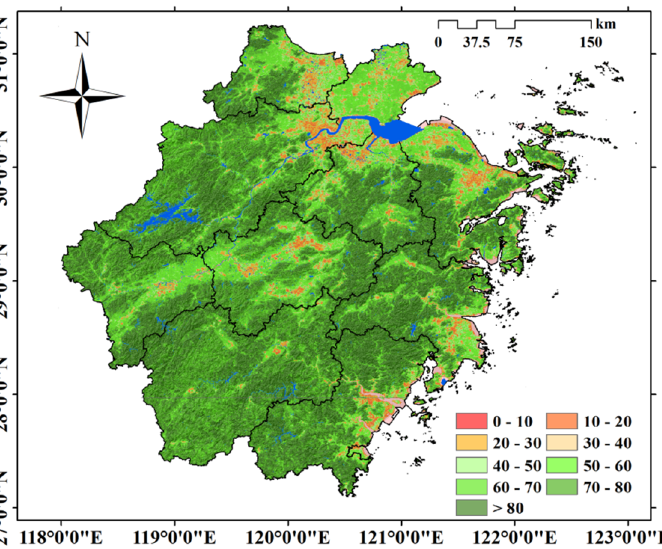
Figure 3. Distribution of VCI in Zhejiang Province (Unit: %).